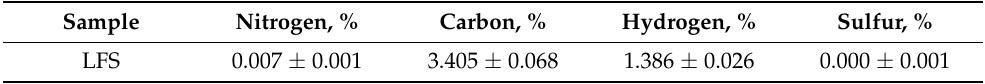
Table 3. Elemental analysis of ladle furnace